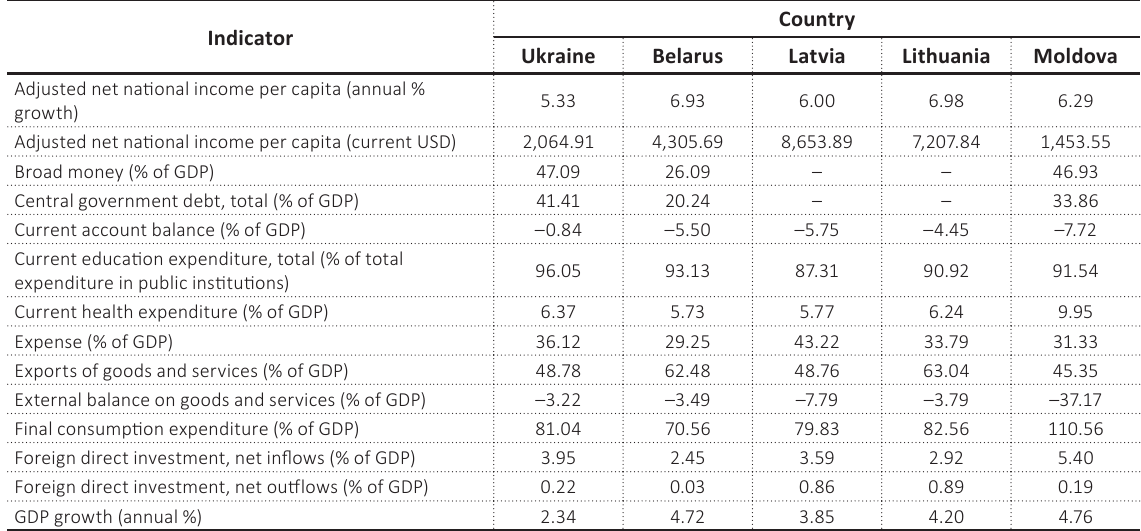
Table 2. General indicators of development of the studied countries’ economies on average for 2010– 2019 in the VUCA world